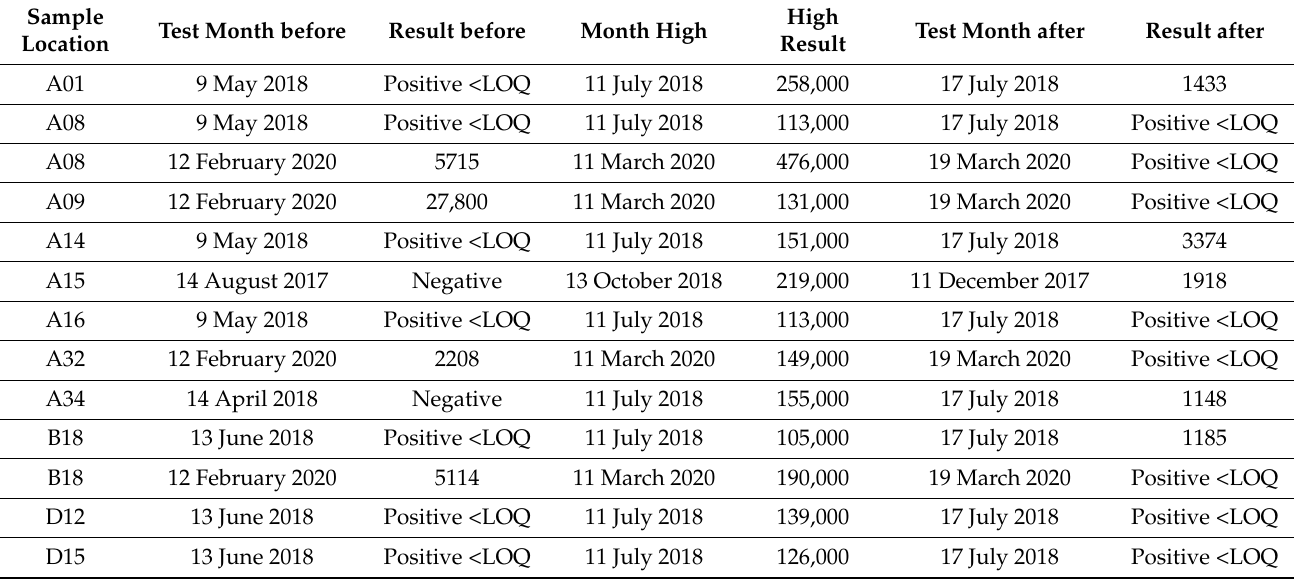
Table 3. Areas with readings >100,000 and values for the samples taken before and after.